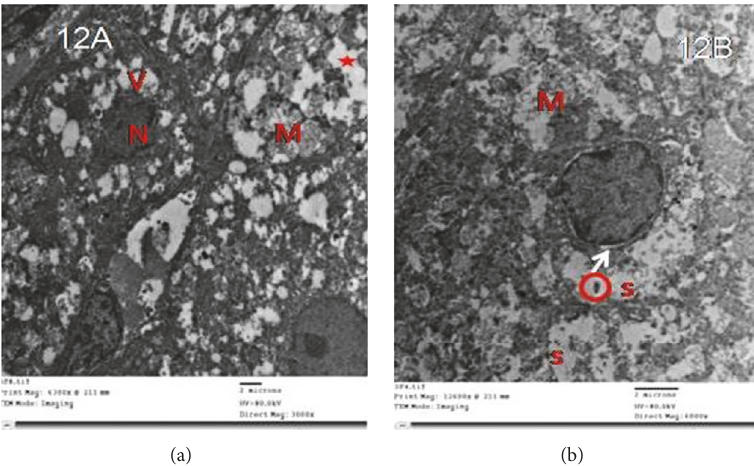
Figure 12: (a) Electron micrographs of zona fasciculata cells of group II showing vacuoles of variable sizes (V), mitochondria with destroyed cristae (M), lipid droplets without discernible outline (L), and a shrunken hyperchromatic nucleus with an irregular outline (N). Note confluent lipid droplets (star). (b) Another cell has an irregular nucleus (N) with dilated perinuclear space (arrow), mitochondria with destroyed cristae (M), and numerous dilated profiles of smooth endoplasmic reticulum (s). Notice cytoplasmic vacuoles with electron-dense cores (circles).